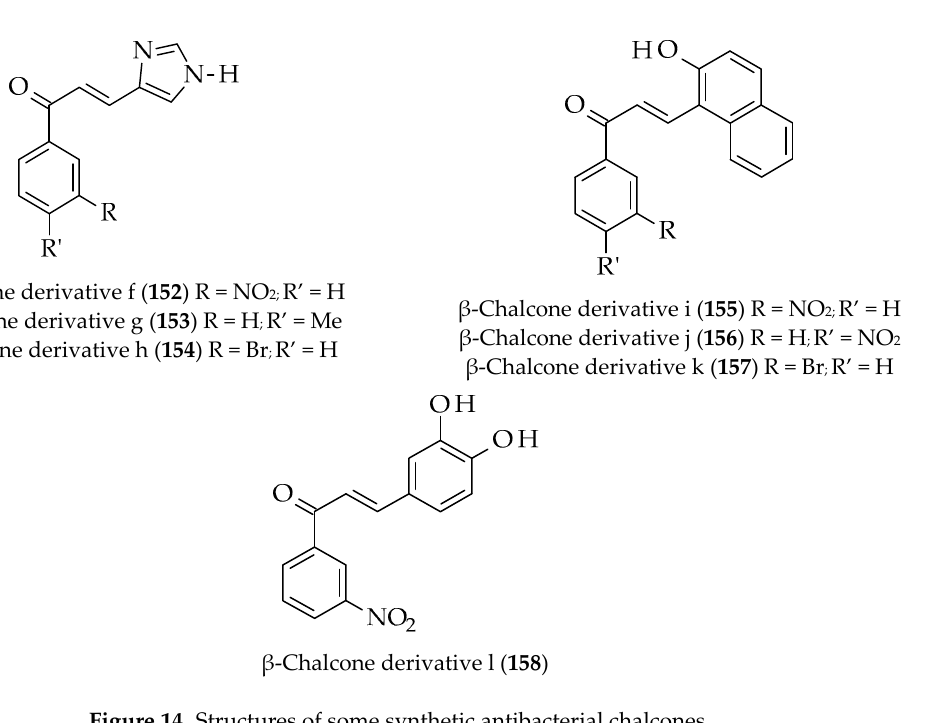
Figure 14. Structures of some synthetic antibacterial chalcones.